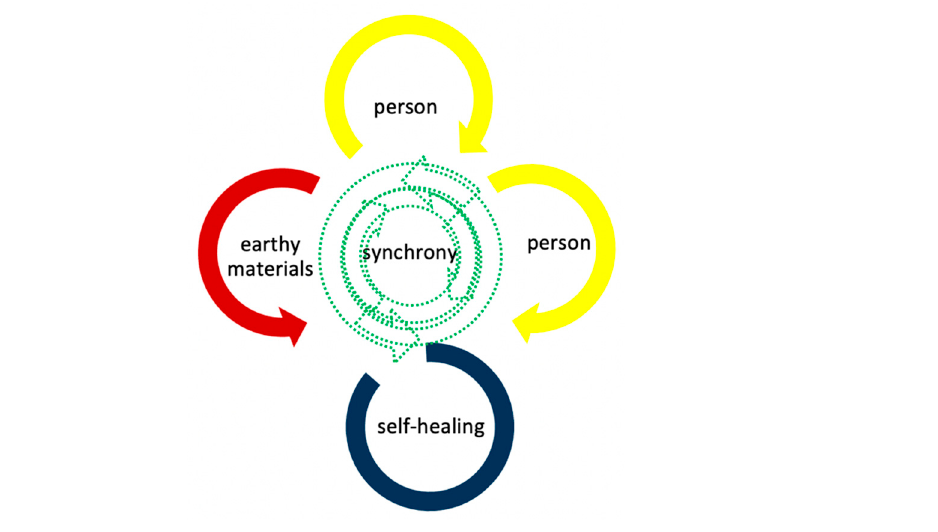
Figure 1. The nature immersion model for healing in the extreme environments.